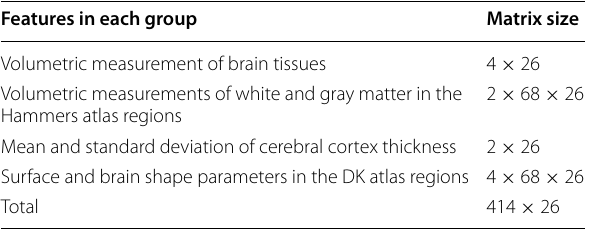
Table 3 Dimensions of feature matrices related to